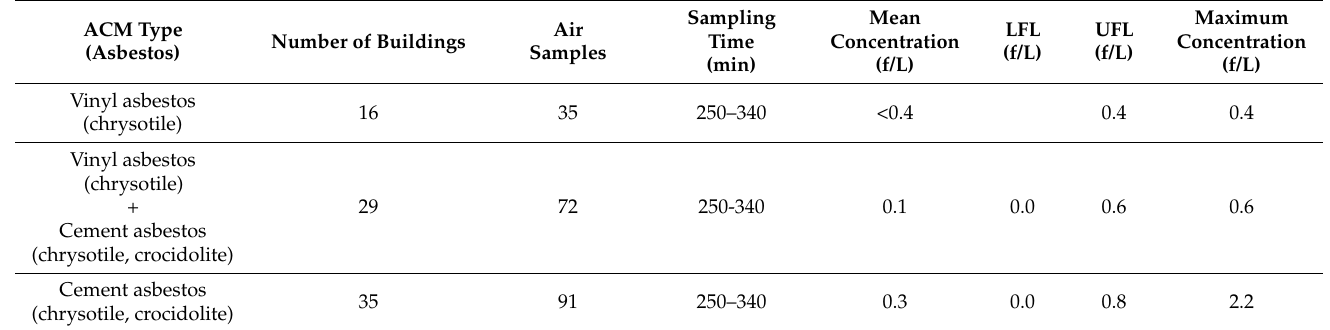
Table 3. Mean airborne asbestos fiber concentration measured in public buildings with non-friable ACMs. LFL, UFL and maximum concentration measured are also shown.